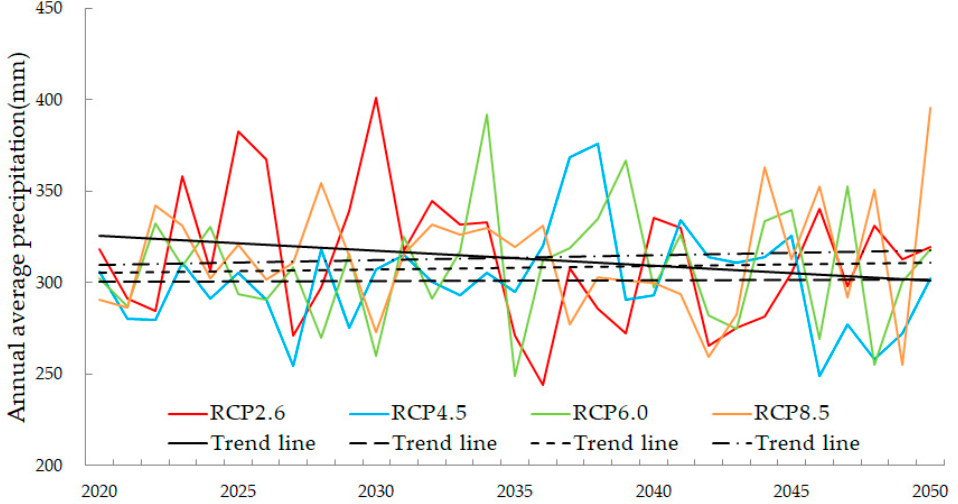
Figure 4. The annual average precipitation of the Bosten Lake basin for RCP scenarios from 2020 to 2050. to 2050.